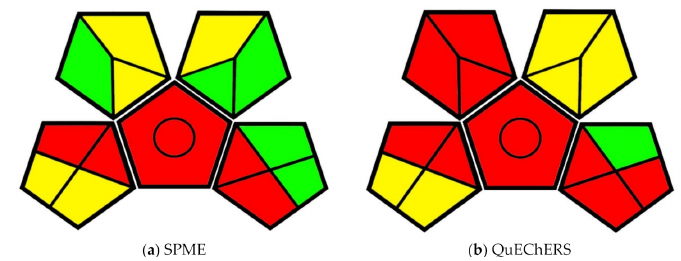
Figure 4. ( a ) GAPI evaluation pictogram for the solid-phase microextraction (SPME) method; ( b ) GAPI evaluation pictogram for the Quick Easy Cheap E ff ective Rugged Safe (QuEChERS) method from Souza-Silva et al., 2013